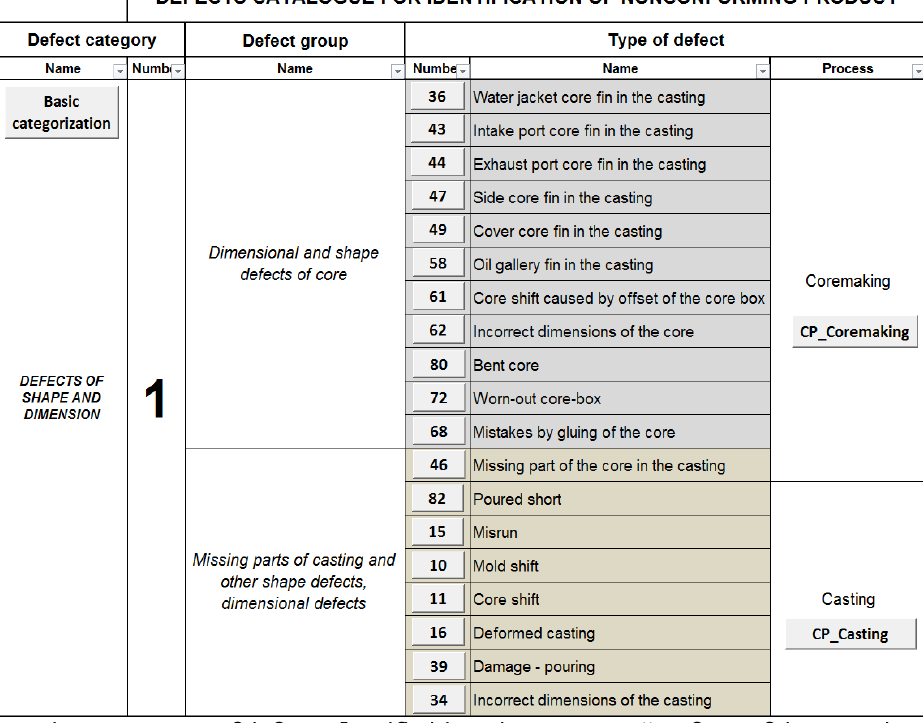
Figure 1 – Part of defects classified into the category “Defects of shape and